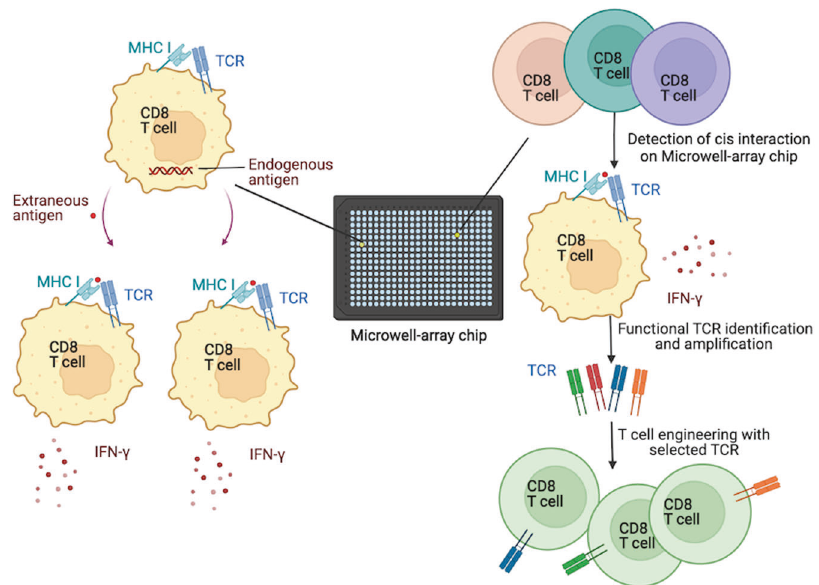
Fig. 1 Illustration of T-ISAAC, a novel TCR cloning system derived from T cells ’ cis activation. T cells could be activated by the cis interaction of TCR and MHC molecules, loaded with endogenous or extraneous antigens. Based on this fi nding, the T-ISAAC system that can ef fi ciently detect and clone human antigen-speci fi c TCRs was developed applying a microwell-array chip coated with biotinylated-cytokine-speci fi c antibodies. The activated T cells selected by IFN- γ secretion was then retrieved and used for TCRs cloning. Then the cloned TCRs could be introduced into T cells for functional assessment. This fi gure was created with